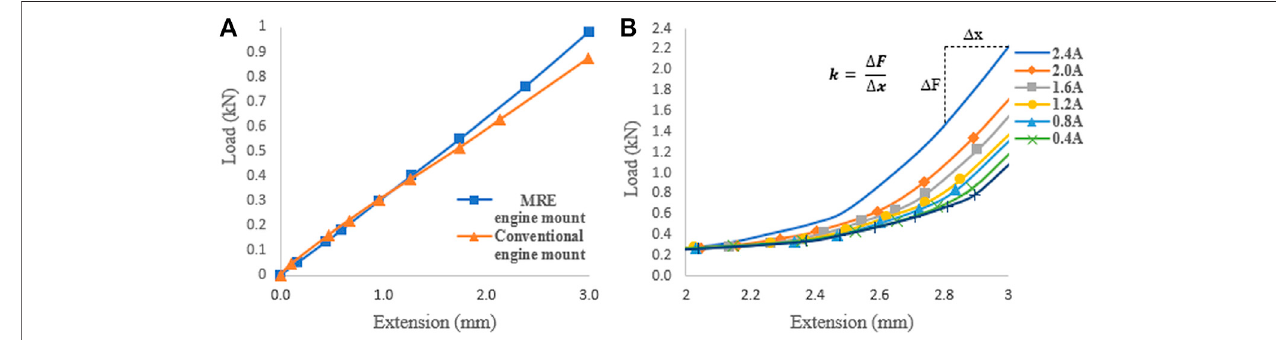
FIGURE 10 | Plotted graph of force vs. displacement in the static compression tests, (A) off-state condition and (B) on-state condition.